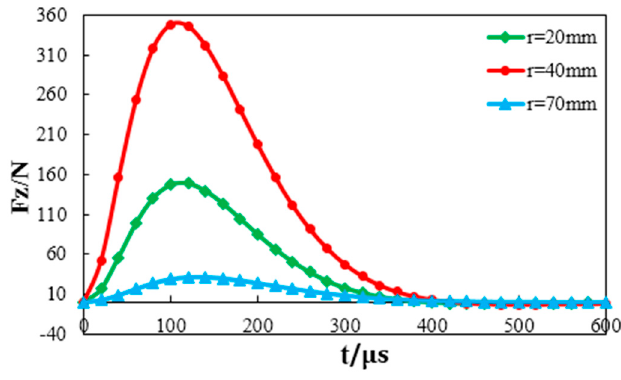
Figure 9. Excitation and loading area.